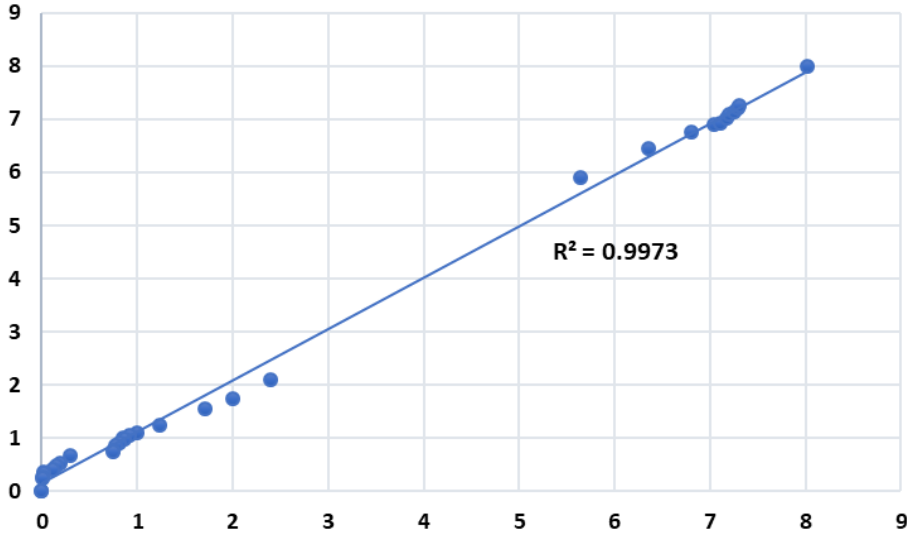
Figure 4. Variation of concentration results of mathematical model vs. experimental. Table 2. Model results and experimental data using MR for BuAc production.